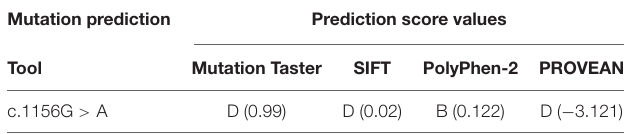
TABLE 1 | Bioinformatics prediction of a pathogenic variant. Mutation prediction Prediction score